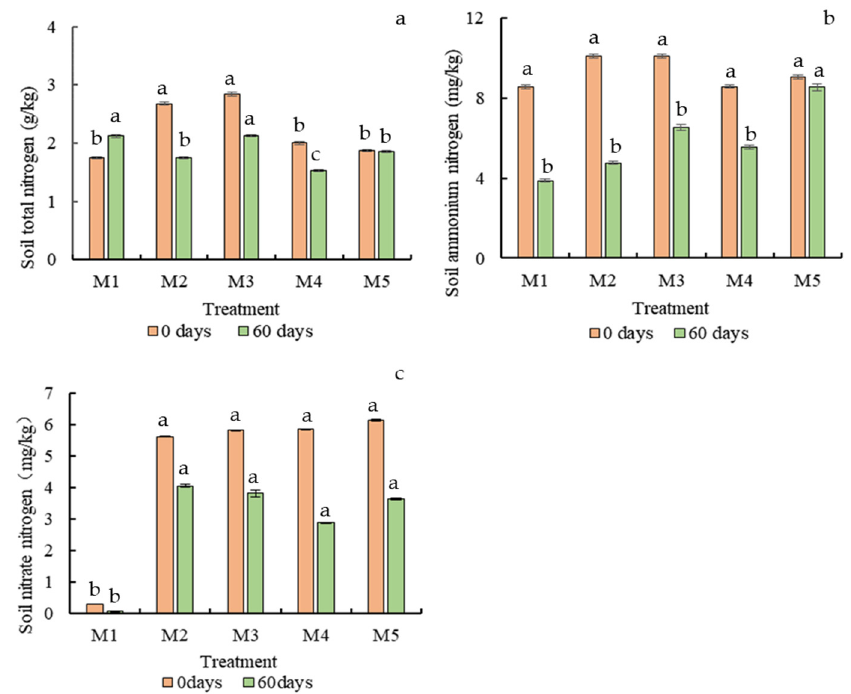
Figure 6. Soil total nitrogen ( a ) (g/kg), ammonium nitrogen ( b ) (mg/kg) and nitrate nitrogen ( c ) (mg/kg) changes at different growth times. Different letters in the same column indicate statistically significant differences among the samples based on one-way ANOVA (LSD, p < 0.05).